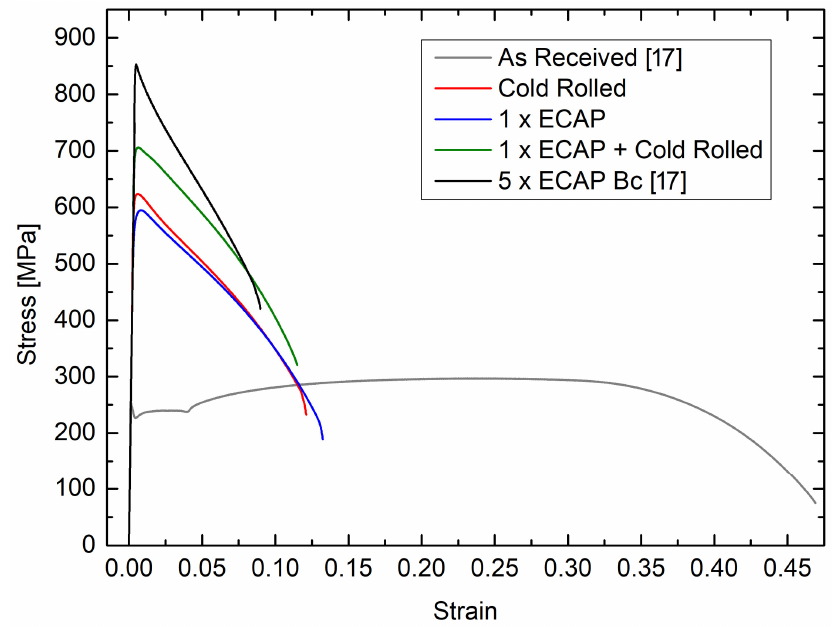
Figure 4. Engineering stress–strain curves for different processing conditions of ARMCO ® iron.